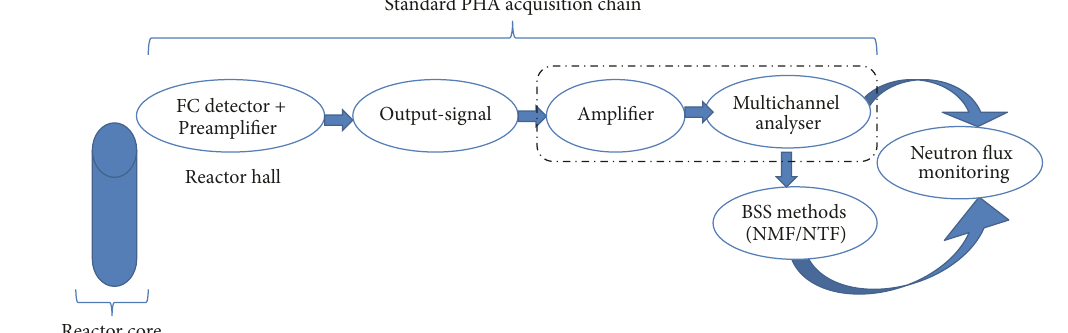
Figure 5: Project steps for the neutron flux monitoring using BSS methods.